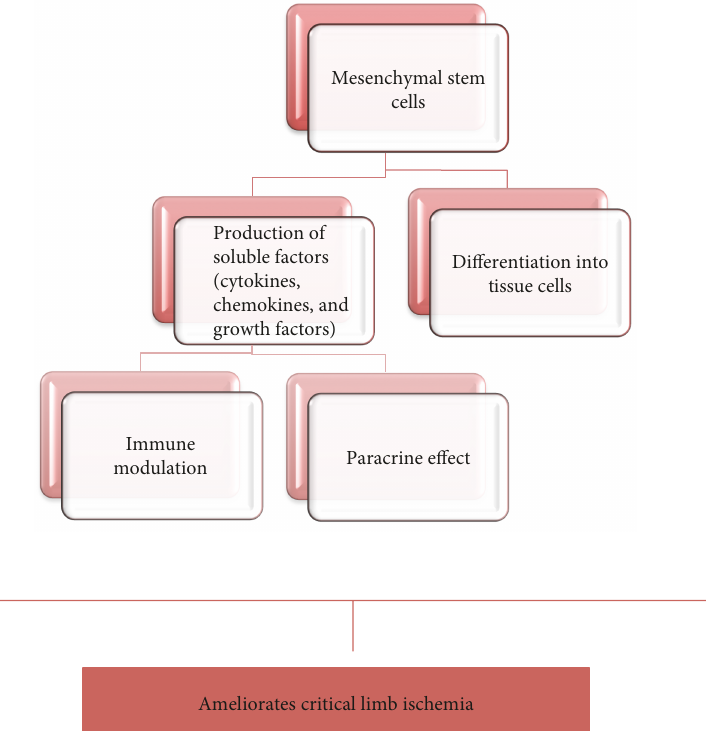
Figure 1: Potential mechanisms of mesenchymal stem cells in treating peripheral artery disease related critical limb